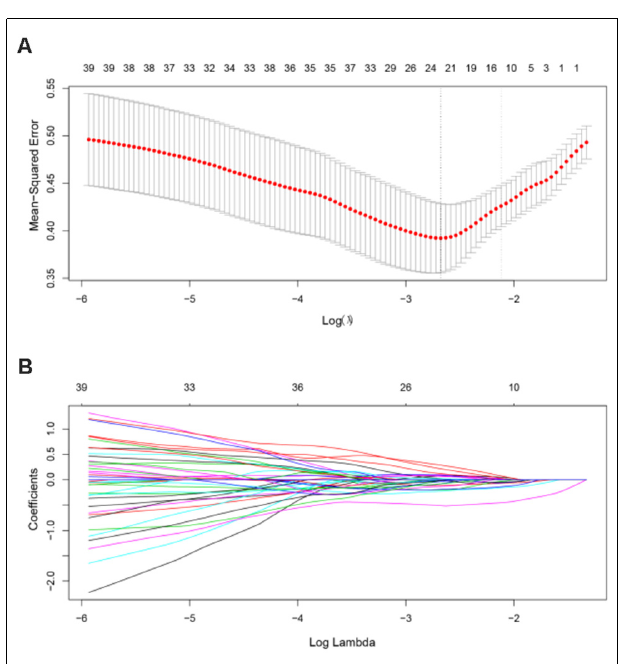
FIGURE 3 | Feature selection using the LASSO model. (A) In the primary dataset, the penalization parameter λ was selected using 10-fold cross-validation LASSO method with the mean squared error (MSE) as the criterion. In this study, the minimum MSE was at λ = 0.069, log( λ ) = –2.68. (B) LASSO coefficient profile of 129 radiomic features. There are 23 nonzero coefficient features at the optimal λ . LASSO, least absolute shrinkage and selection